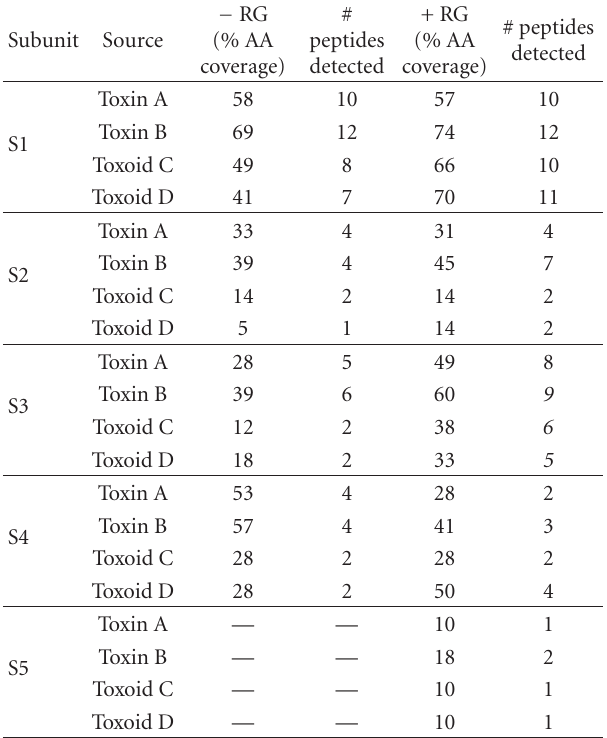
Table 3: Comparative pertussis toxin and toxoid subunit sequence analysis ( − /+ rapigest